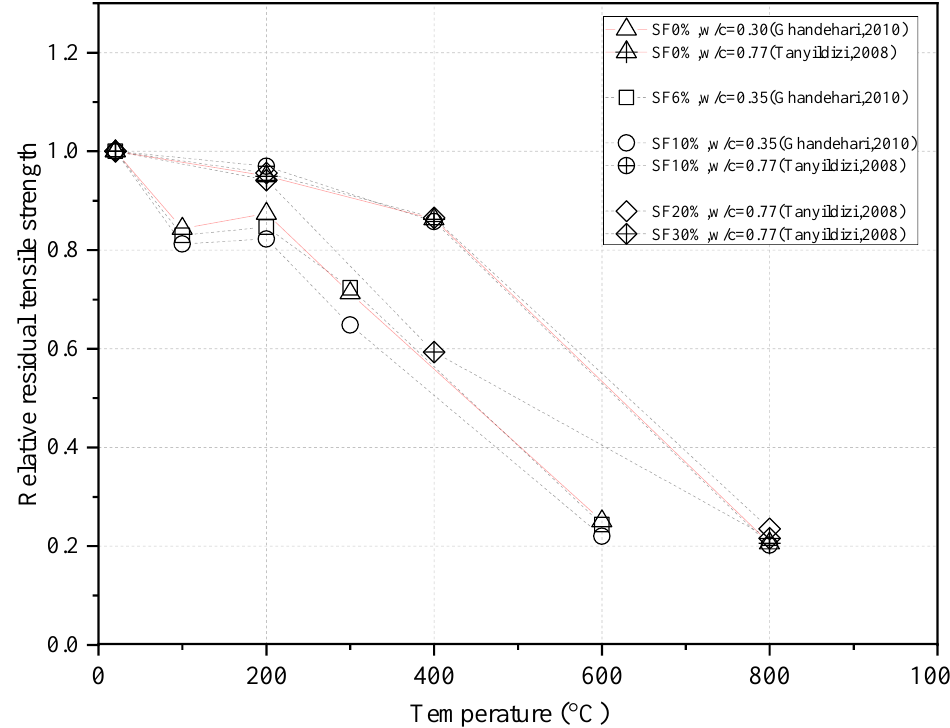
Figure 4. The relative residual tensile strength of concrete containing silica fume (SF) at different water-to-cementitious materials ratios (w/c) [16,36].